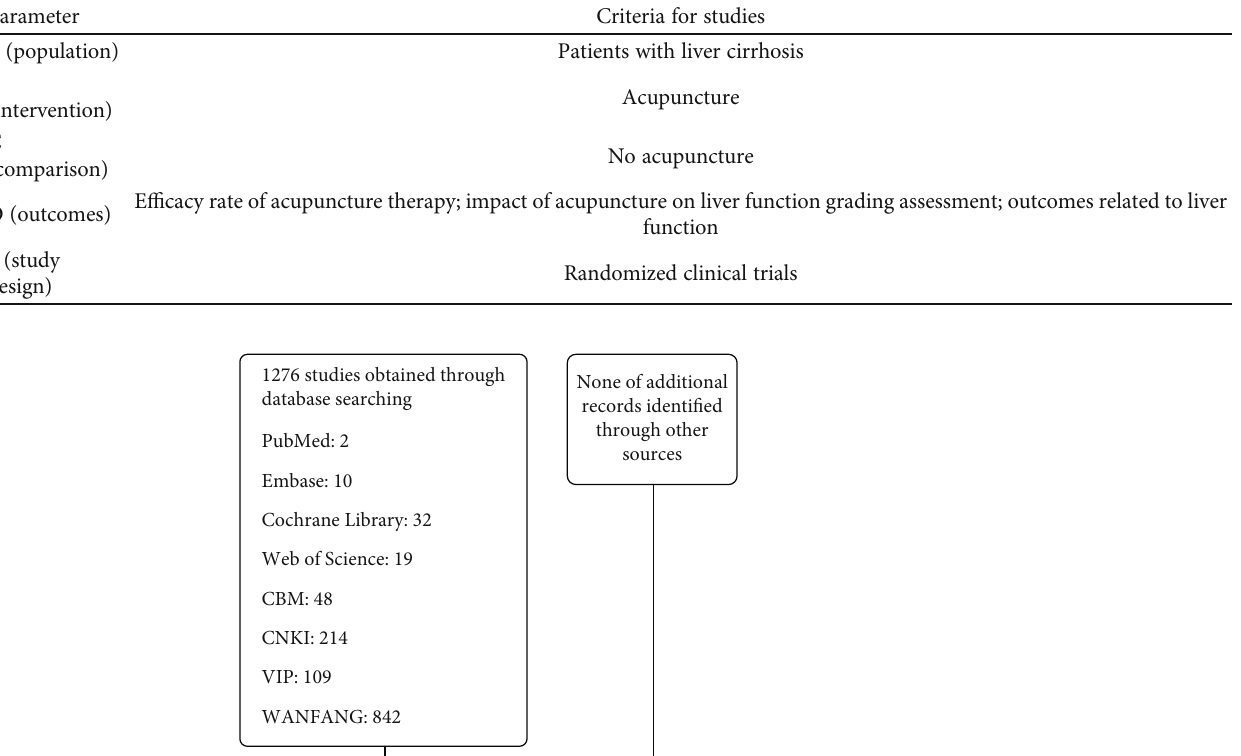
Table 1: PICOS criteria for study selection.